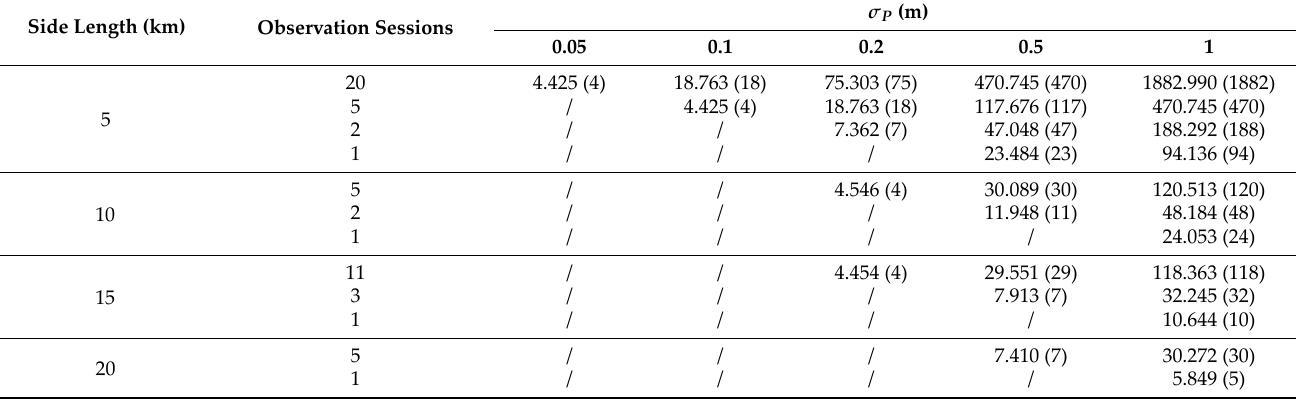
Table 6. The position of the weakest point under different side lengths and observation sessions when the number of the equilateral triangle unit network is